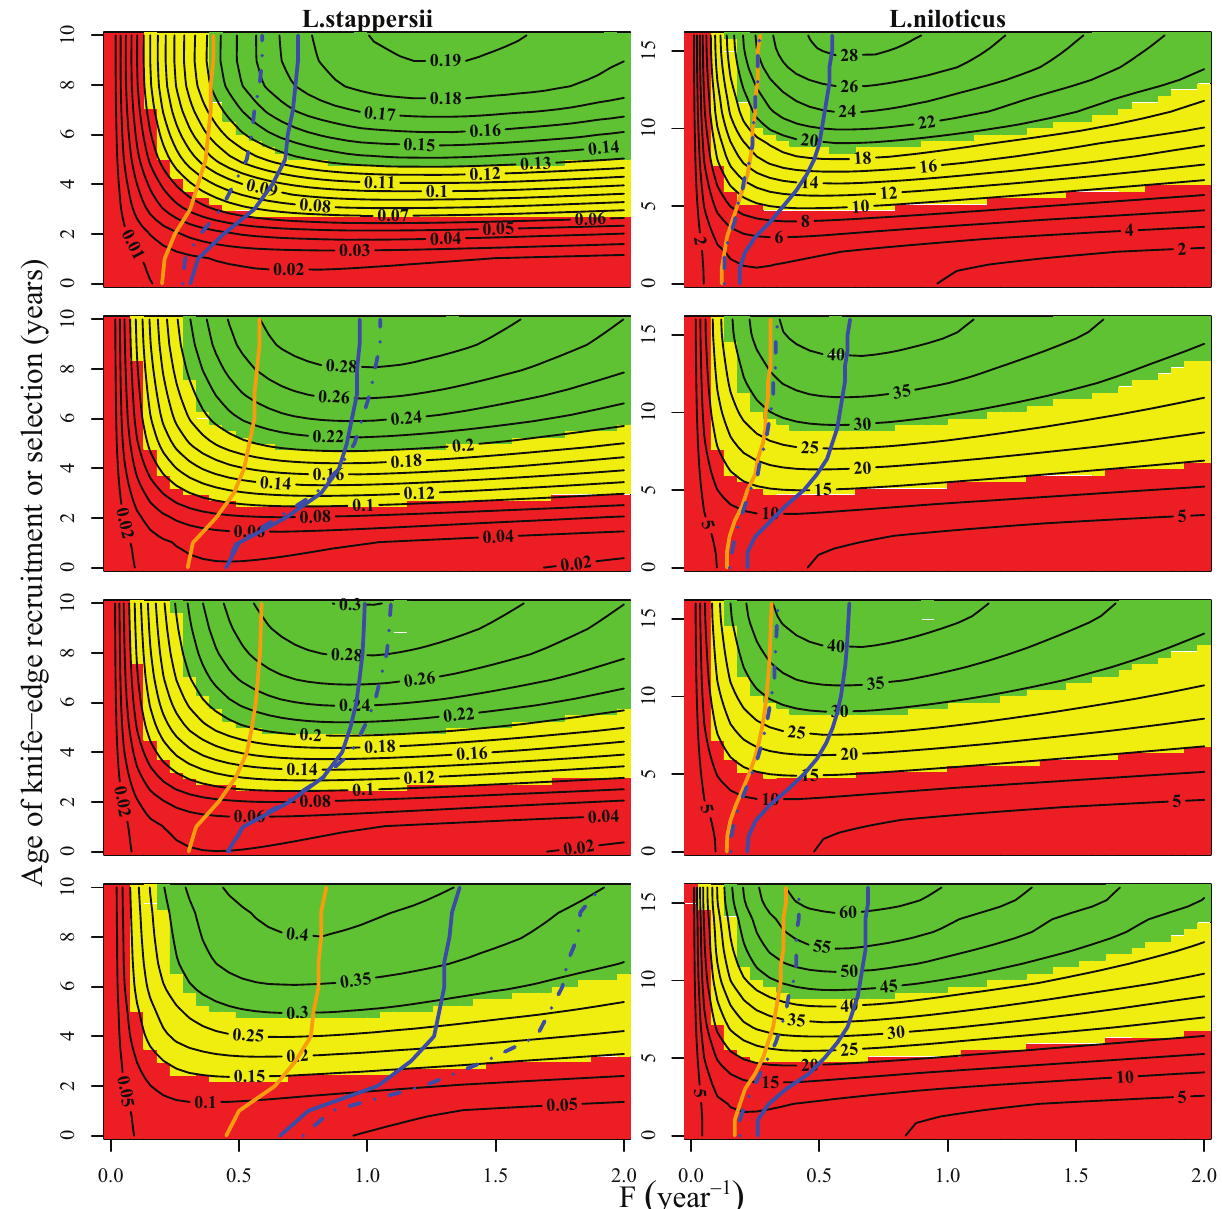
Fig. 2. Isopleths of, from top to bottom, the 2.5% percentile, median, mean, and 97.5% percentile of CYPR m.s. (kg) as a function of fi shing mortality ( F ) and the age of knife-edge recruitment or of knife-edge selection for L. stappersii in Lake Tanganyika (left panels) and L. niloticus in Lake Victoria (right panels). The plots also show the eumetric fi shing curves of the 2.5% percentile, median, mean, and 97.5% percentile of F CYPR (blue solid line), F 0.1 (orange solid line), as well as F 35%CSPR for L. stappersii and F 40%CSPR for L. niloticus (blue dash-dotted line) against the age of knife-edge recruitment. Areas shaded by the red color, yellow color, and green color are, respectively, topographies of low CYPR, intermediate CYPR, and high CYPR. If F CYPR , F 0.1 , or F at a target CSPR is treated as the fi shing mortality target, the region below and to the right of the corresponding lines represents growth-over fi